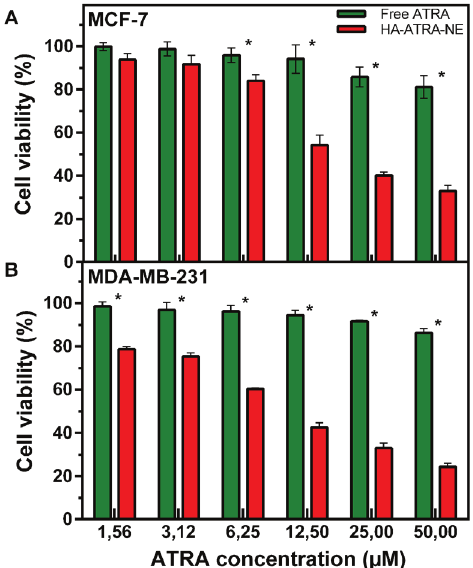
FIGURE 6 – Cell metabolic viability of MCF-7 (A) and MDA- MB-231 (B) after 48 hours of exposure to blank NE, ATRA- loaded NE, and free ATRA. Data represented as mean ± SD (n =